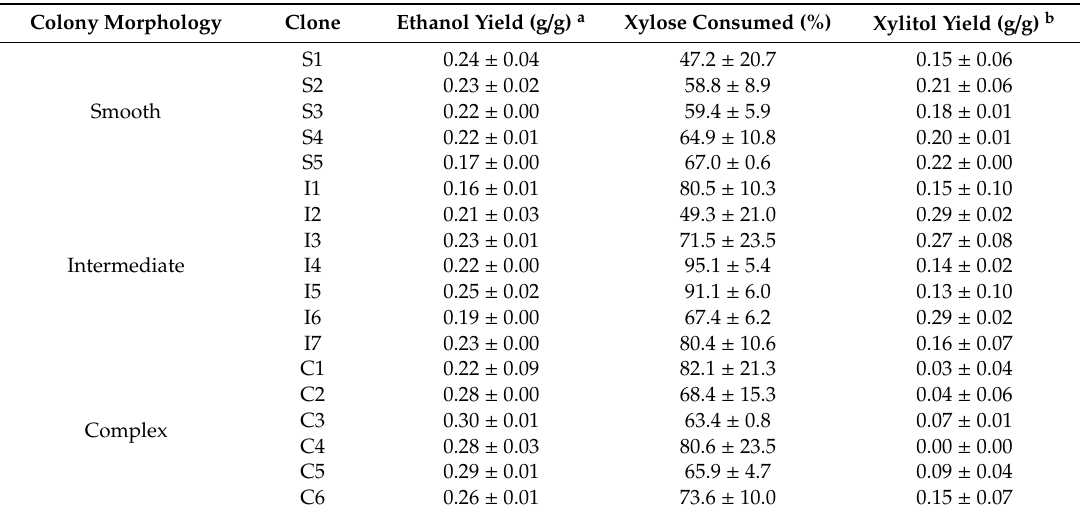
Table 1. Ethanol yield, percentage of xylose consumed and xylitol yield obtained after 72 h of fermentation of 20% ( v / v ) wheat straw hydrolysate with di ff erent isolated C. intermedia clones. Colony Morphology